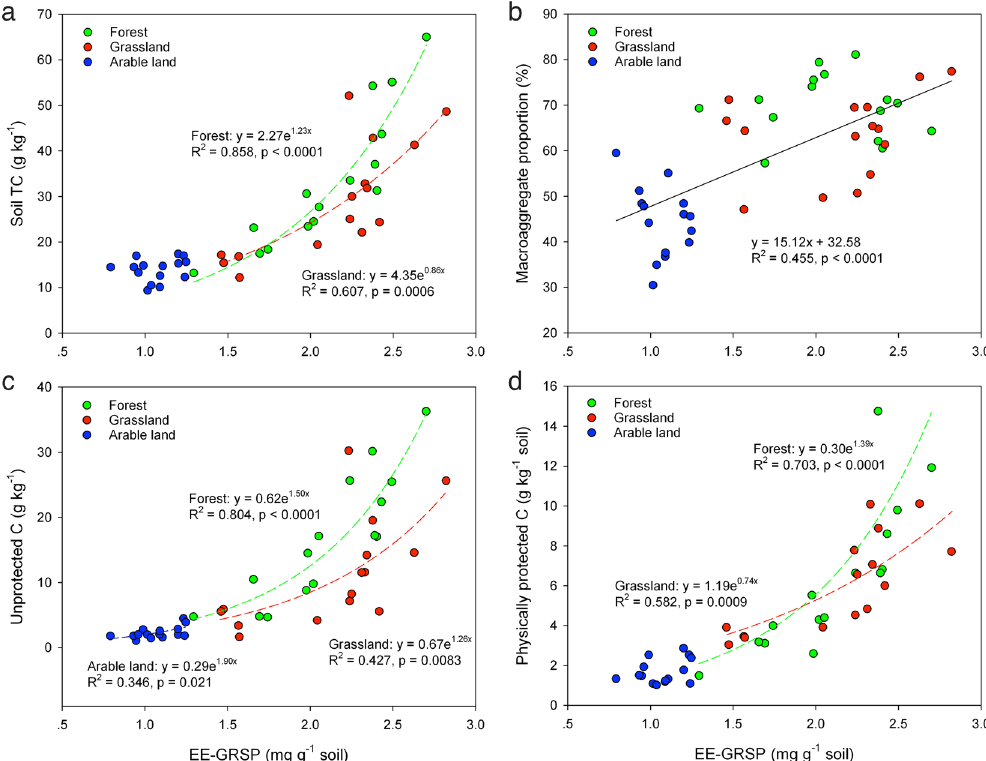
Figure 4. Relationships between EE-GRSP and soil C storage and soil aggregation. Regression analyses showing the relationship between EE-GRSP and ( a ) soil TC, ( b ) proportion of macroaggregates, and ( c ) C concentrations in the unprotected C fraction and ( d ) physically protected C fraction. In a, c and d, the dashed line with the same color of symbols indicates the predicted relationship between EE-GRSP and soil C storage for each land use type. In b, the solid line indicates the predicted relationship between EE-GRSP with soil aggregation across all three land use